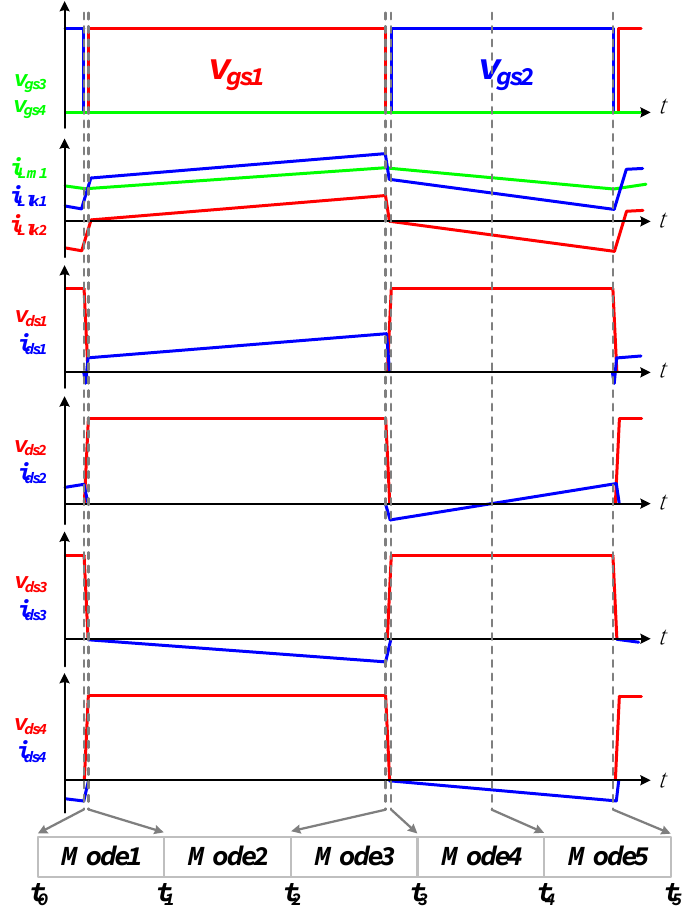
Figure 4. Key waveforms of the proposed topology in the step-up mode.